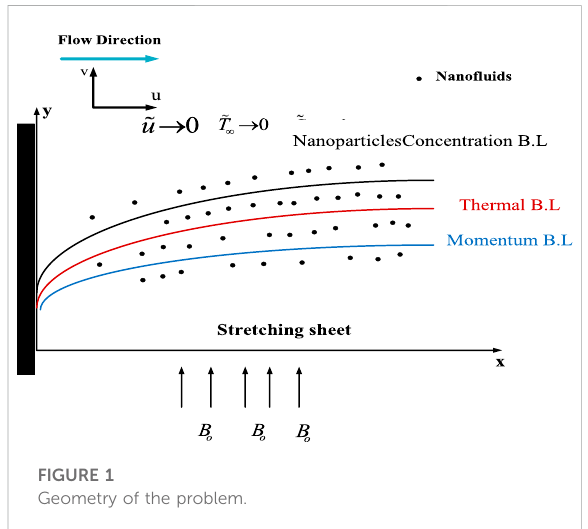
FIGURE 1 Geometry of the